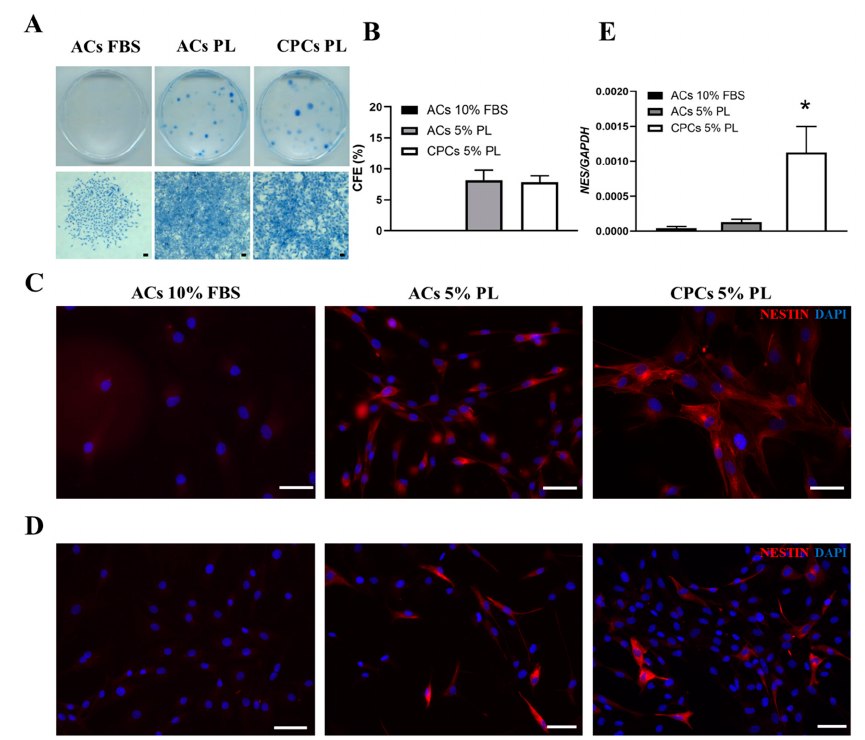
Figure 4. Clonogenic potential and detection of nestin expression in ACs-FBS, ACs-PL and CPCs-PL derived from articular cartilage tissue. ( A ) Colony-Forming Unit Fibroblast (CFU-F) assay for ACs isolated in 10% FBS, ACs treated with 5% PL and CPCs recruited by 5% PL from cartilage chips: cell colony staining in culture dish (upper panel) and magnification of stained colony cells (bottom panel). ( B) Histogram reporting the colony forming efficiency (CFE) calculated for the three experimental groups. Data are represented as mean ± SEM ( N = 10, no statistically significant difference by Student’s t -test analysis). ( C ) Immunofluorescence staining for nestin in CFU-F cells/dish of the three examined groups. ( D ) Immunofluorescence staining for nestin in the three experimental groups. ( E ) Expression level of the stem cell marker nestin ( NES ) in ACs 10% FBS, ACs 5% PL and CPCs 5% PL determined by qRT-PCR. Data are represented as mean ± SEM ( N = 5, * p < 0.05 versus ACs 5% PL by Mann–Whitney test analysis). All scale bars correspond to 100 µ